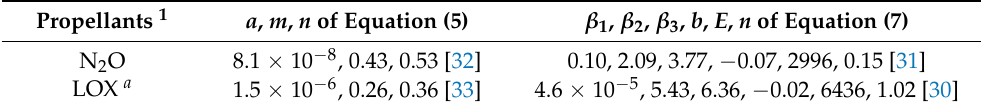
Table 4. Empirical constants of Equations (5) and